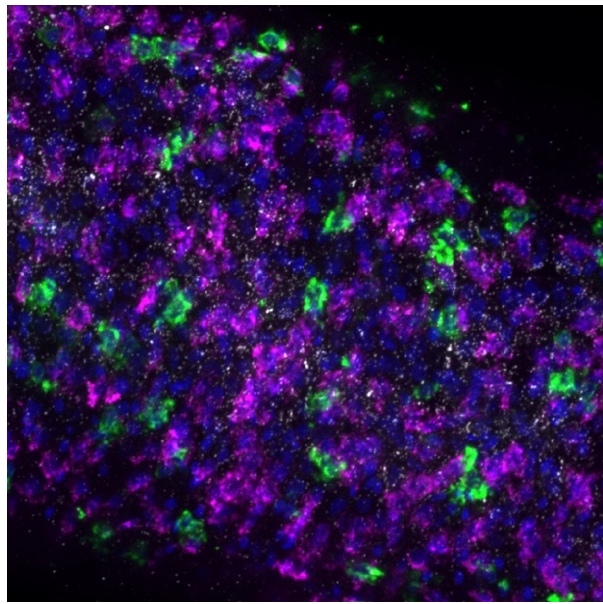
Figure 10. Fluorescence in situ hybridization of SmSULT . Body section of male worm showing SmSULT distribution. Cells positive for SmSULT stained positive for TAMRA-Tyramide, magenta. DAPI (blue) was used at a final concentration of 1 ug/mL to stain cell nuclei. FITC-positive cells are Schistosoma stem cells, positive for Schistosoma histone H2B [30,31]. SmSULT and H2B probes were used at a final concentration of 150 ng/mL. FISH was performed on 4–5 whole worms.